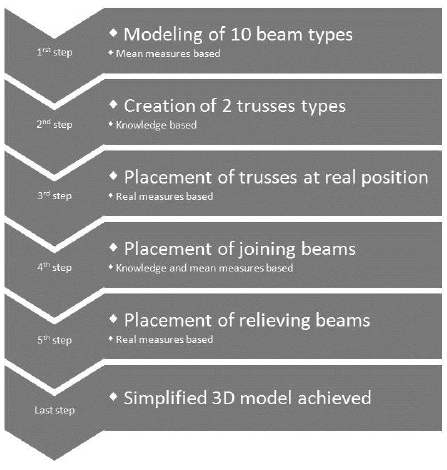
Figure 6: Modelling process in Trimble Sketchup